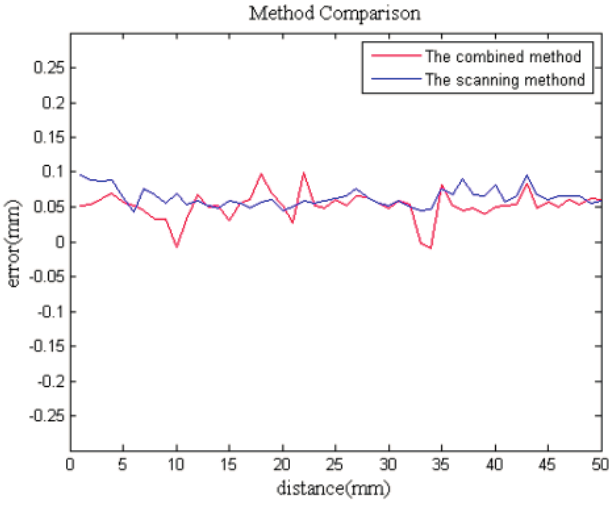
Figure 12. The results of the deviation comparison.